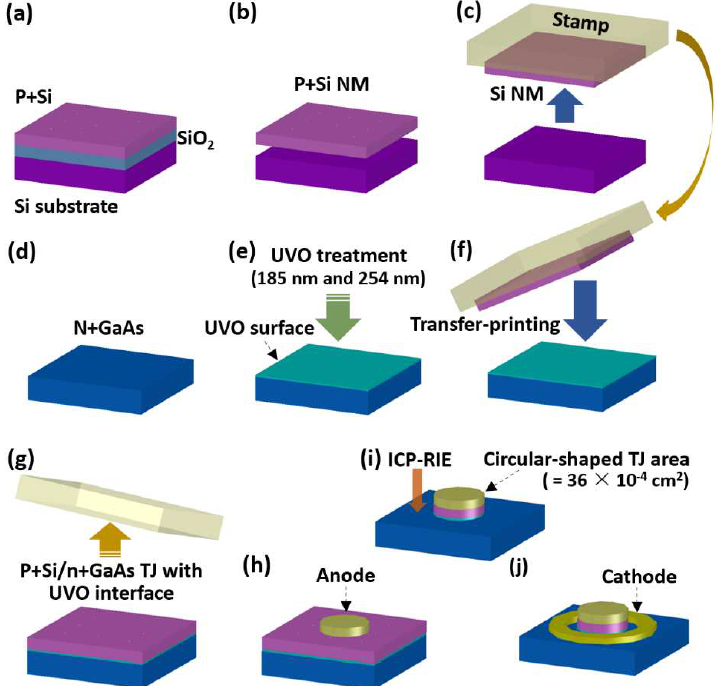
Figure 3. Process steps for p+Si/n+GaAs TJ diodes with UVO-treated interface. ( a ) Preparation of p+Si on the insulator wafer, ( b ) undercut sacrificial SiO 2 layer, leading to the formation of the H-terminated p+Si NM, ( c ) gathering of Si NM using an elastomeric stamp, ( d ) preparation of the n+GaAs substrate, ( e ) formation of O-terminated n+GaAs through UVO treatment, ( f ) transfer printing of the Si NM on the UVO-treated GaAs, ( g ) formation of p+Si/n+GaAs TJs with a